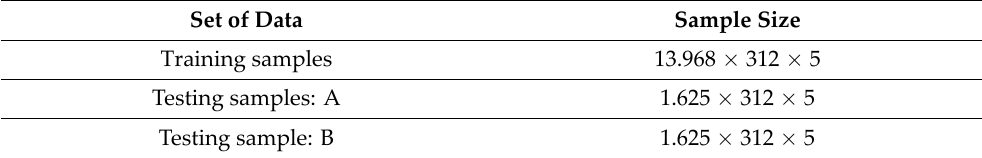
Table 2. Utilization of